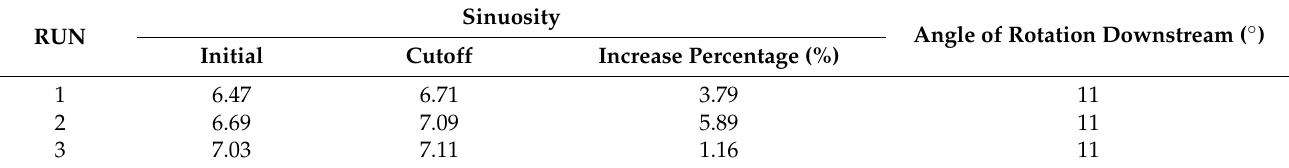
Figure 9. Comparison between ( a ) the initial terrain and the final terrain after cutoff with ( b ) the topography of the relative equilibrium in RUN2 and ( c ) the topography of the relative equilibrium in RUN3. The white line represents the measured cross section. The yellow line on the right marks the length. 3.4. Channel Response to Neck Cutoff The water surface gradients within the scope of S7–S13 in the upstream area, S13–S21 in the bend area, and S21–S26 in the downstream area were represented by S u , S c , and S d , respectively, and the change trends are shown in Figure 10. Before cutoff, the three gradi- ents fluctuated with discharge, and the change trends of S u and S d were the same, but the change trend of S c differed from these two trends. Before cutoff, S c was the highest, and after cutoff, S c sharply dropped, while both S u and S d increased. At t = 0–130 h before cutoff in RUN2, the three gradient fluctuation ranges were 1.1–5.0‰, 2.0–4.5‰, and 1.3–2.2‰, respectively. When cutoff was imminent, i.e., at t = 130 h, S c was the highest, at 3.7‰, S u was moderate, at 1.8‰, and S d was the lowest, at 1.1‰. After cutoff, both S u and S d in- creased, but S d increased more. Due to backwater in the bend area, S c sharply decreased. Under an experimental duration of t = 136 h, S u and S d were 2.8‰ and 4.2‰, respectively, which were 57.7% and 287.5% higher, respectively, than that before cutoff; meanwhile, S c decreased to 0.4‰, which was 89.4% lower than that before cutoff. At t = 0–60 h before cutoff in RUN3, the three gradient fluctuation ranges were 0.9–2.0‰, 0.7–1.9‰, and 0.1– 1.6‰, respectively. Near cutoff, i.e., when the experimental duration reached t = 60 h, S u , S c , and S d were 1.0‰, 1.8‰, and 0.8‰, respectively. S c was still the highest. After cutoff (experimental duration t = 63 h), S u and S d increased to 1.1‰ and 2.6‰, respectively, which were 7.1% and 247.1% higher than those before cutoff, respectively; S c decreased to 0.1‰, which was 94.7% lower than that before cutoff.